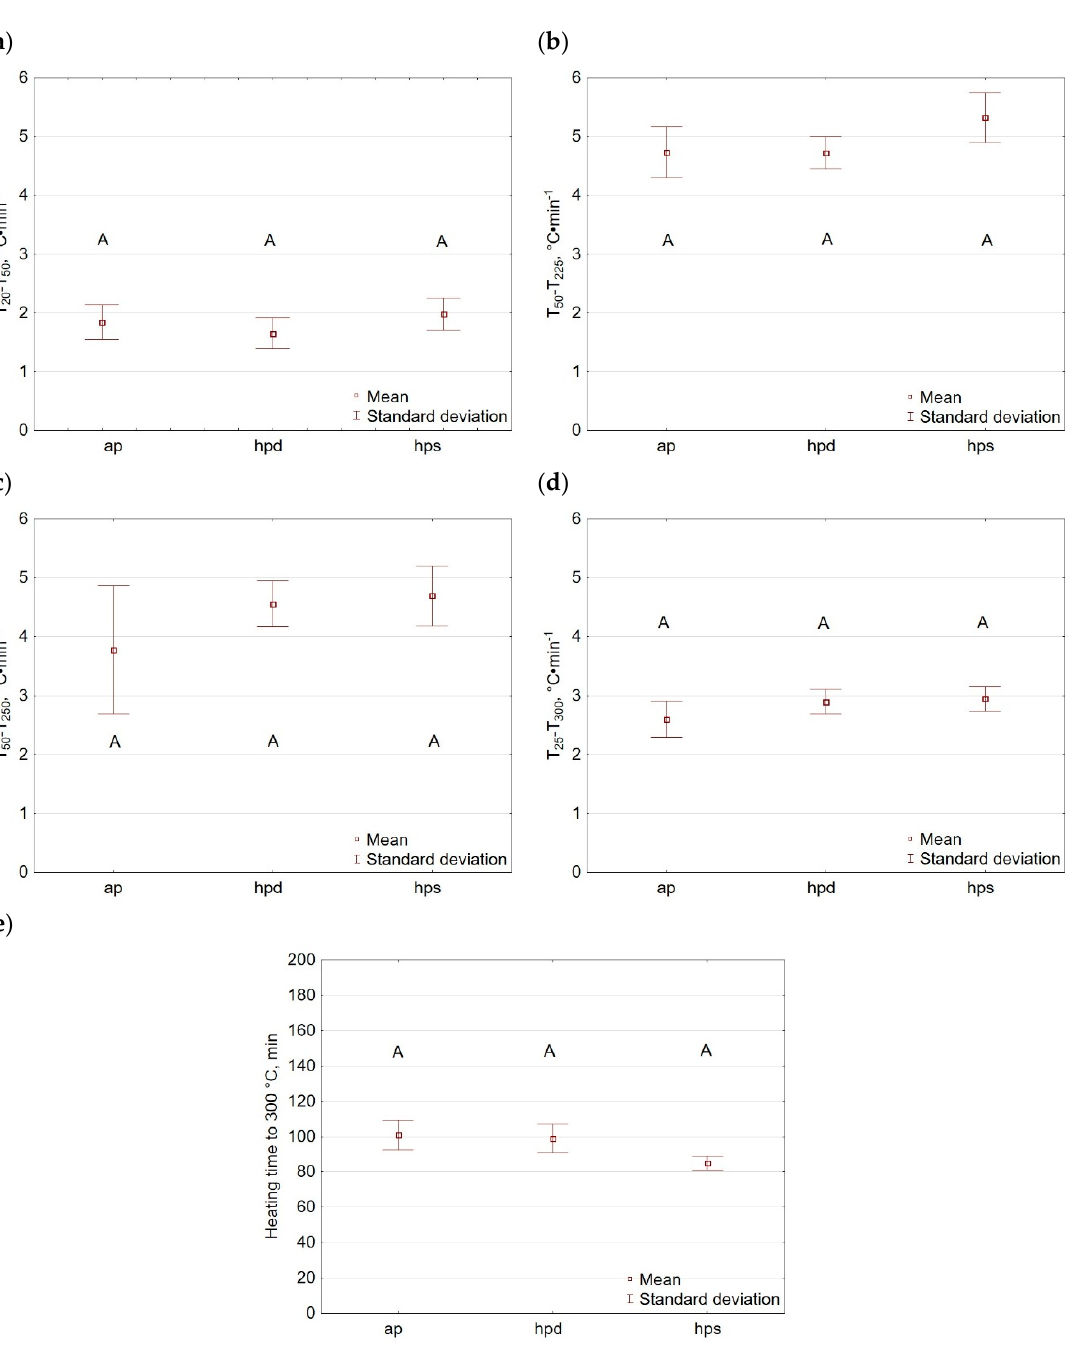
Figure 7. The heating rate of the reactor and heating time to setpoint temperature for a particular torrefaction process, ( a ) heating rate from 20 to 50 ◦ C, ( b ) heating rate from 50 to 225 ◦ C, ( c ) heating rate from 50 to 250 ◦ C, ( d ) heating rate from 25 to 300 ◦ C, ( e ) heating time up to 300 ◦ C. Di ff erent heating rates resulted in the starting point of the torrefaction process on the timeline scale. In the case of ap, the torrefaction started in ~101 min of the experiment, while in the case of hpd and hps in ~99, and ~85 min, respectively, the starting points did not di ff er significantly ( p < 0.05) (Figure